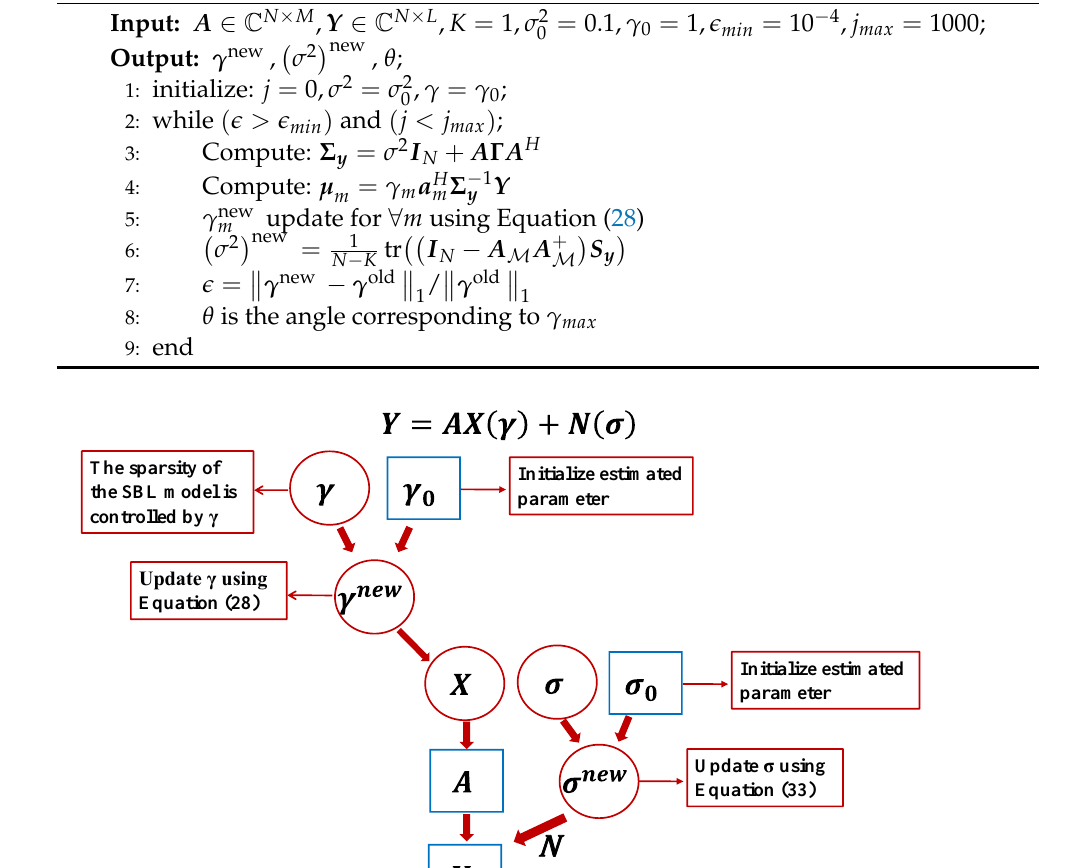
Algorithm 1: The SBL-based infrasound source orientation algorithm